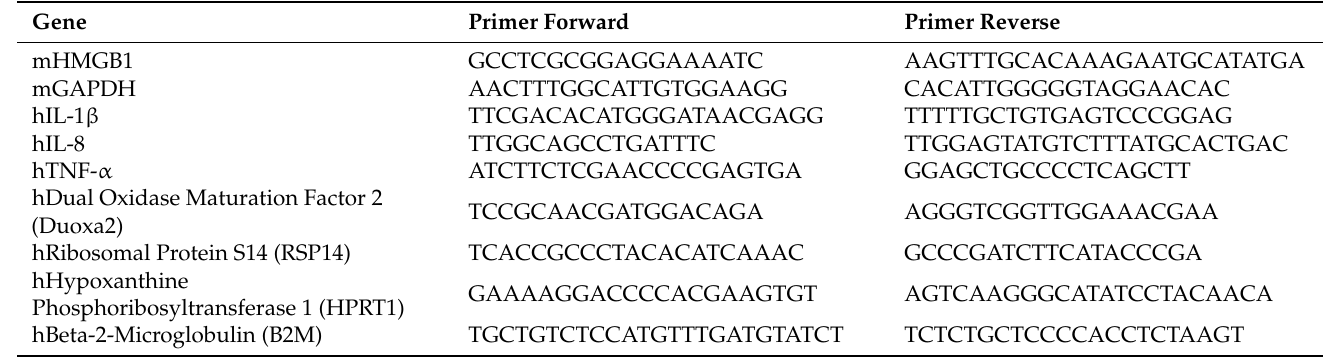
Table 1. List of primers for real-time